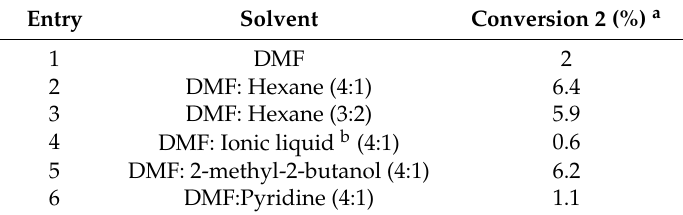
Table 1. The effect of solvent in the palmitoylation of DHPA catalysed by Lew-CAL-B.